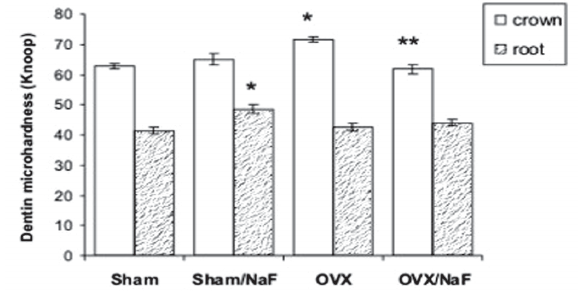
FIGURE 2- Dentin microhardness of the maxillary incisor of sham and OVX female rats treated with fluoride (sham and OVX/NaF) or distilled water (sham and OVX). *P<0.05 vs sham; **P<0.05 vs OVX;